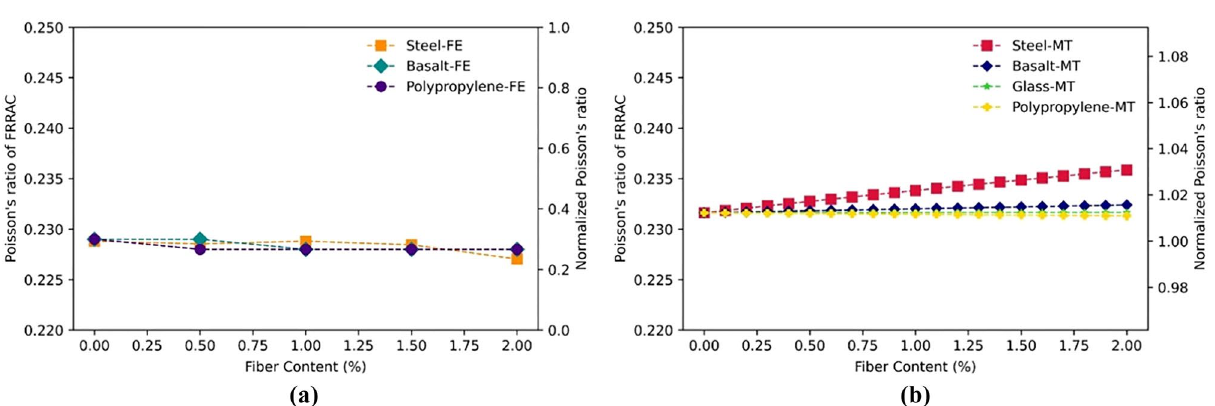
Figure 9. The elastic modulus of FRRAC based on fiber content: ( a ) FE approach, ( b ) MT approach.